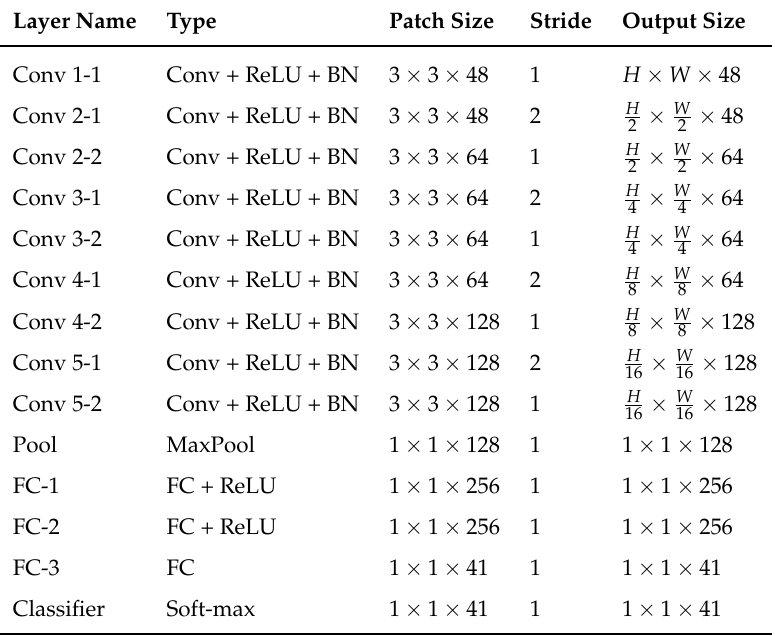
Table 1. Architecture of Sub-Network